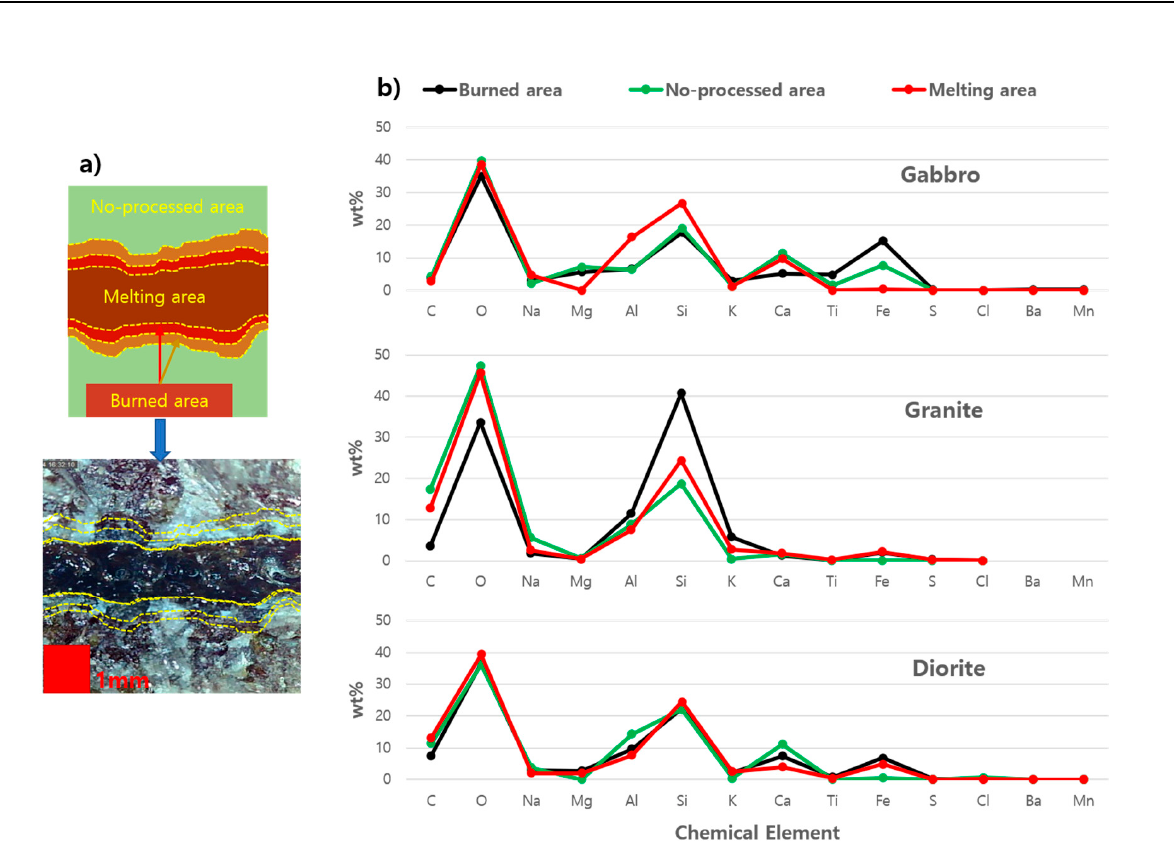
Figure 5. ( a ) Specimen observation tactics diagram and ( b ) EDX analyses of three different regions of gabbro, granite, and diorite.